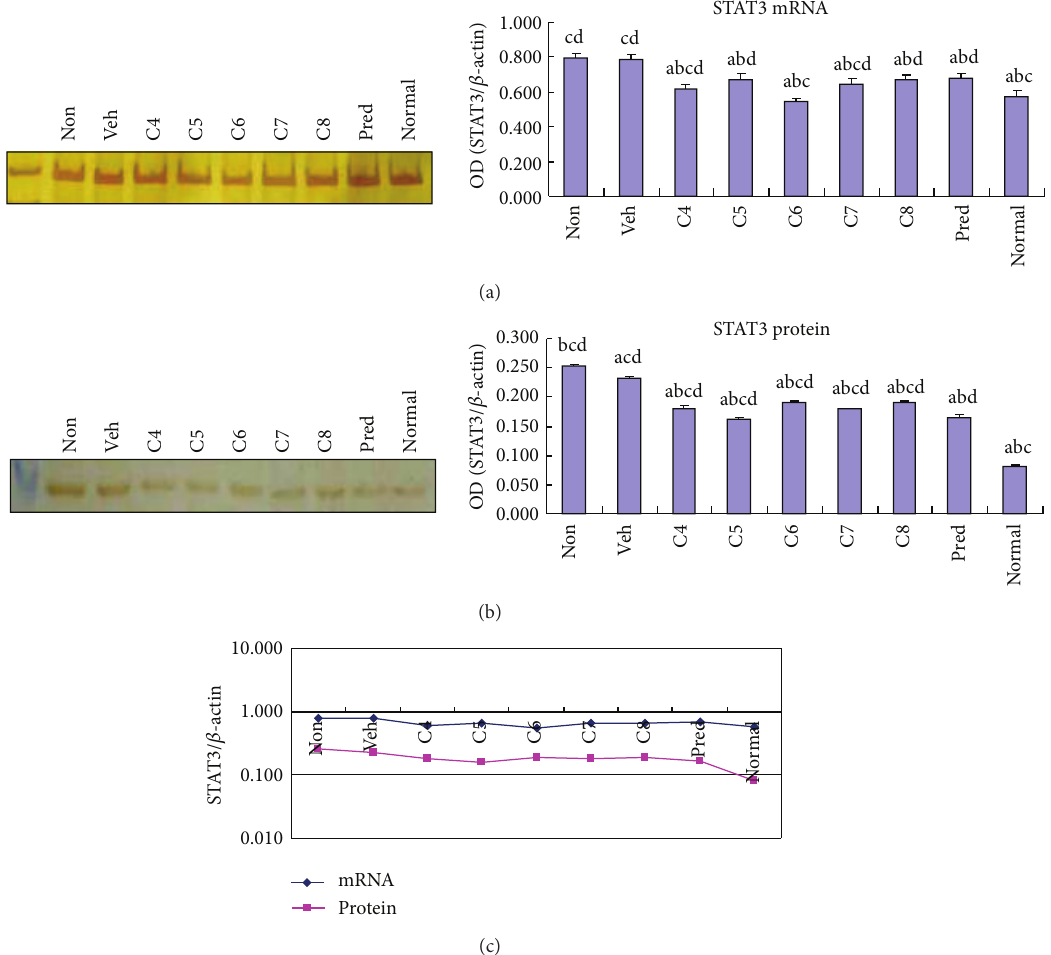
Figure 5: Lactobacillus acidophilus administration decreased STAT3 expression in colitis. The mRNA (a) and protein (b) levels of STAT3 expression were examined by RT-PCR and Western blotting, respectively, in the colonic tissues of normal control mice group (normal) and DSS-induced mice groups, including L. acidophilus -treated C4–C8 groups, prednisone acetate treated positive control (Pred), and nontreated (Non) and vehicle (Veh) treated control groups. Representative electrophoresis images are shown on the left, and bar graphs presenting mean ± SD ( 𝑛 = 8 ) values are shown on the right. A plotted trendline chart shows STAT3 expression in each group at both mRNA and protein levels (c). a 𝑃 < 0.05 versus Non, b 𝑃 < 0.05 versus Veh, c 𝑃 < 0.05 versus Pred, and d 𝑃 < 0.05 versus